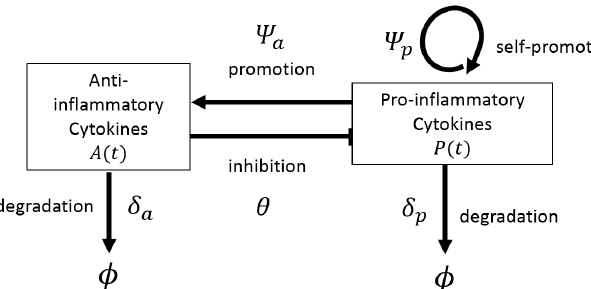
Figure 3. Schematic describing the chemicals and processes included in model described in [44]. The models considers two variables, the pro-inflammatory cytokines and anti-inflammatory cytokines, and their interactions with each other. Note that, here φ represents objects removed from the system. The interactions depicted in this diagram are described by Equation (2), where A ( t ) represents the density of anti-inflammatory cytokines at time t , and P ( t ) represents the density of pro-inflammatory cytokines at time t . These two variables are shown in the two rectangles appearing in the figure above. The arrows between theses two rectangles correspond to the interactions described by the terms in the right-hand side of Equation